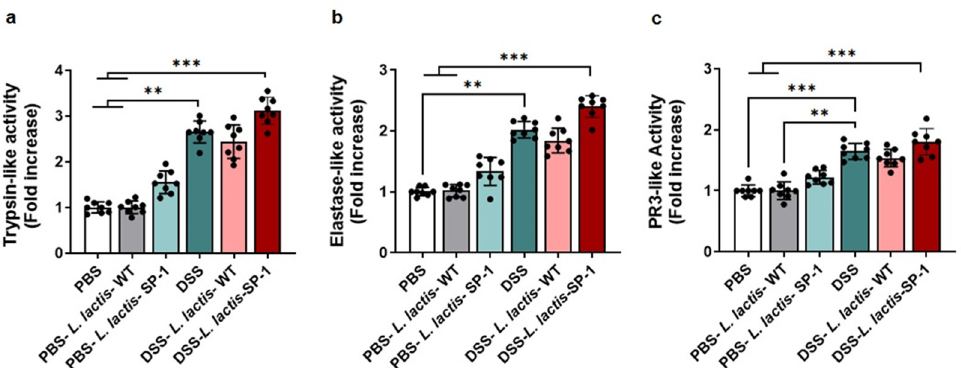
Figure A1. Profiling fecal serine protease activity. ( a ) Fecal trypsin-like activity detected in each group (PBS = 2.25 ± 0.12 U/mg, PBS- L. lactis -WT = 2.28 ± 0.14 U/mg, PBS-L. lactis -SP-1 = 3.5 ± 0.2 U/mg, DSS = 6.01 ± 0.3 U/mg, DSS- L. lactis -WT = 5.48 ± 0.15 U/mg, DSS- L. lactis -SP-1 = 7.04 ± 0.2 U/mg). ( b ) Fecal elastase-like activity measurement (PBS = 2.01 ± 0.08 U/mg, PBS- L. lactis -WT = 2.06 ± 0.07 U/mg, PBS- L. lactis- SP-1 = 2.79 ± 0.2 U/mg, DSS = 4.26 ± 0.13 U/mg, DSS- L. lactis -WT = 3.62 ± 0.2 U/mg, DSS- L. lactis -SP-1 = 4.81 ± 0.17 U/mg). ( c ) Fecal PR3-like activity measurement (PBS = 1.7 ± 0.09 U/mg, PBS- L. lactis -WT = 1.71 ± 0.14 U/mg, PBS- L. lactis -SP-1 = 2.05 ± 0.1 U/mg, DSS = 2.81 ± 0.1 U/mg, DSS- L. lactis -WT = 2.66 ± 0.15 U/mg, DSS- L. lactis -SP-1 = 3.03 ± 0.2 U/mg). The error bars represent the SEM. Data are presented as mean ± SEM. Statistical analyses were performed using Kruskal–Wallis followed by the multi comparison test of Dunn. * p < 0.05; ** p < 0.01 and *** p < 0.001.